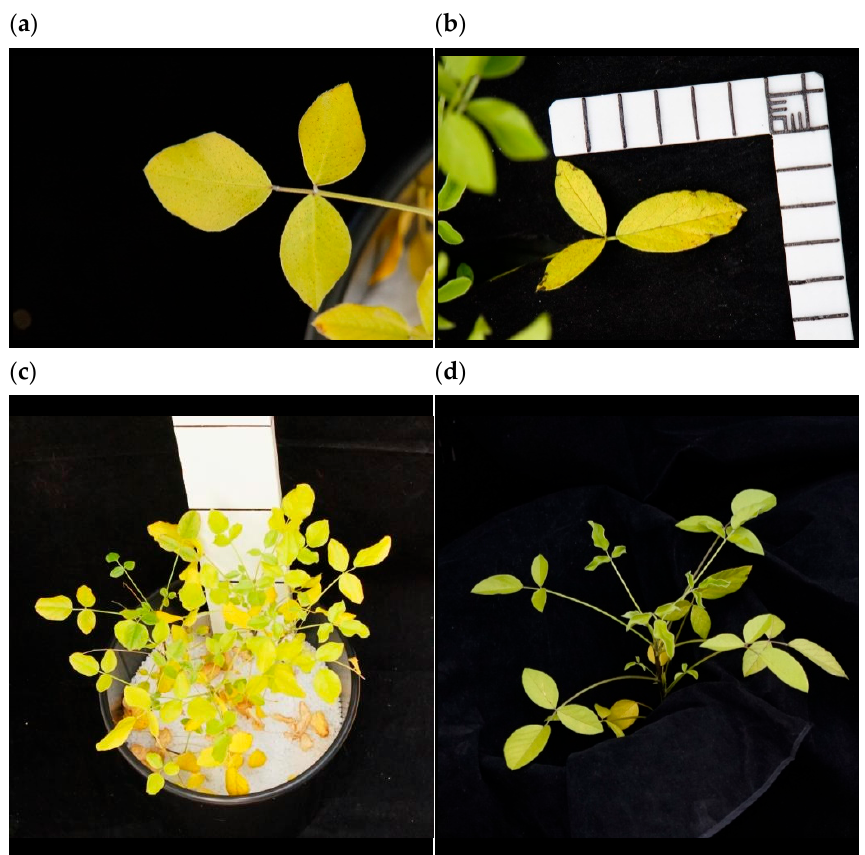
Figure 10. Leaf and whole plant symptoms of Lanza ® tedera ( a , c ) and Palma ( b , d ) grown in soils with very low sulphur (<2 mg kg − 1 ). Photos were taken at 12 weeks old, except panel (d), taken at 8 weeks old.